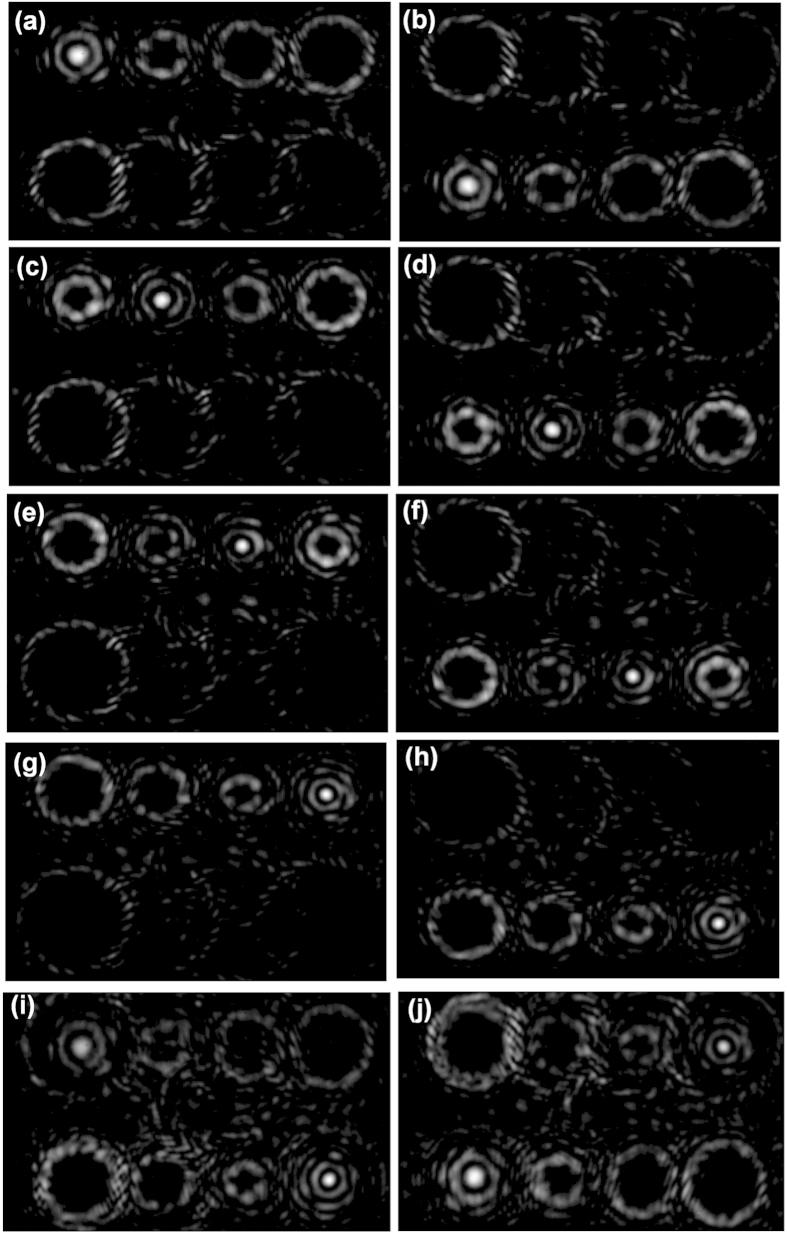
Measured intensity profiles for (a) OAM−6, (b) OAM6, (c) OAM−9, (d) OAM9, (e) OAM−12, (f) OAM12, (g) OAM−15, (h) OAM15, (i) OAM−6, OAM15 and (j) OAM−15, OAM6 demultiplexing.The eight demultiplexed beams are steered in two rows (rectangular shape).